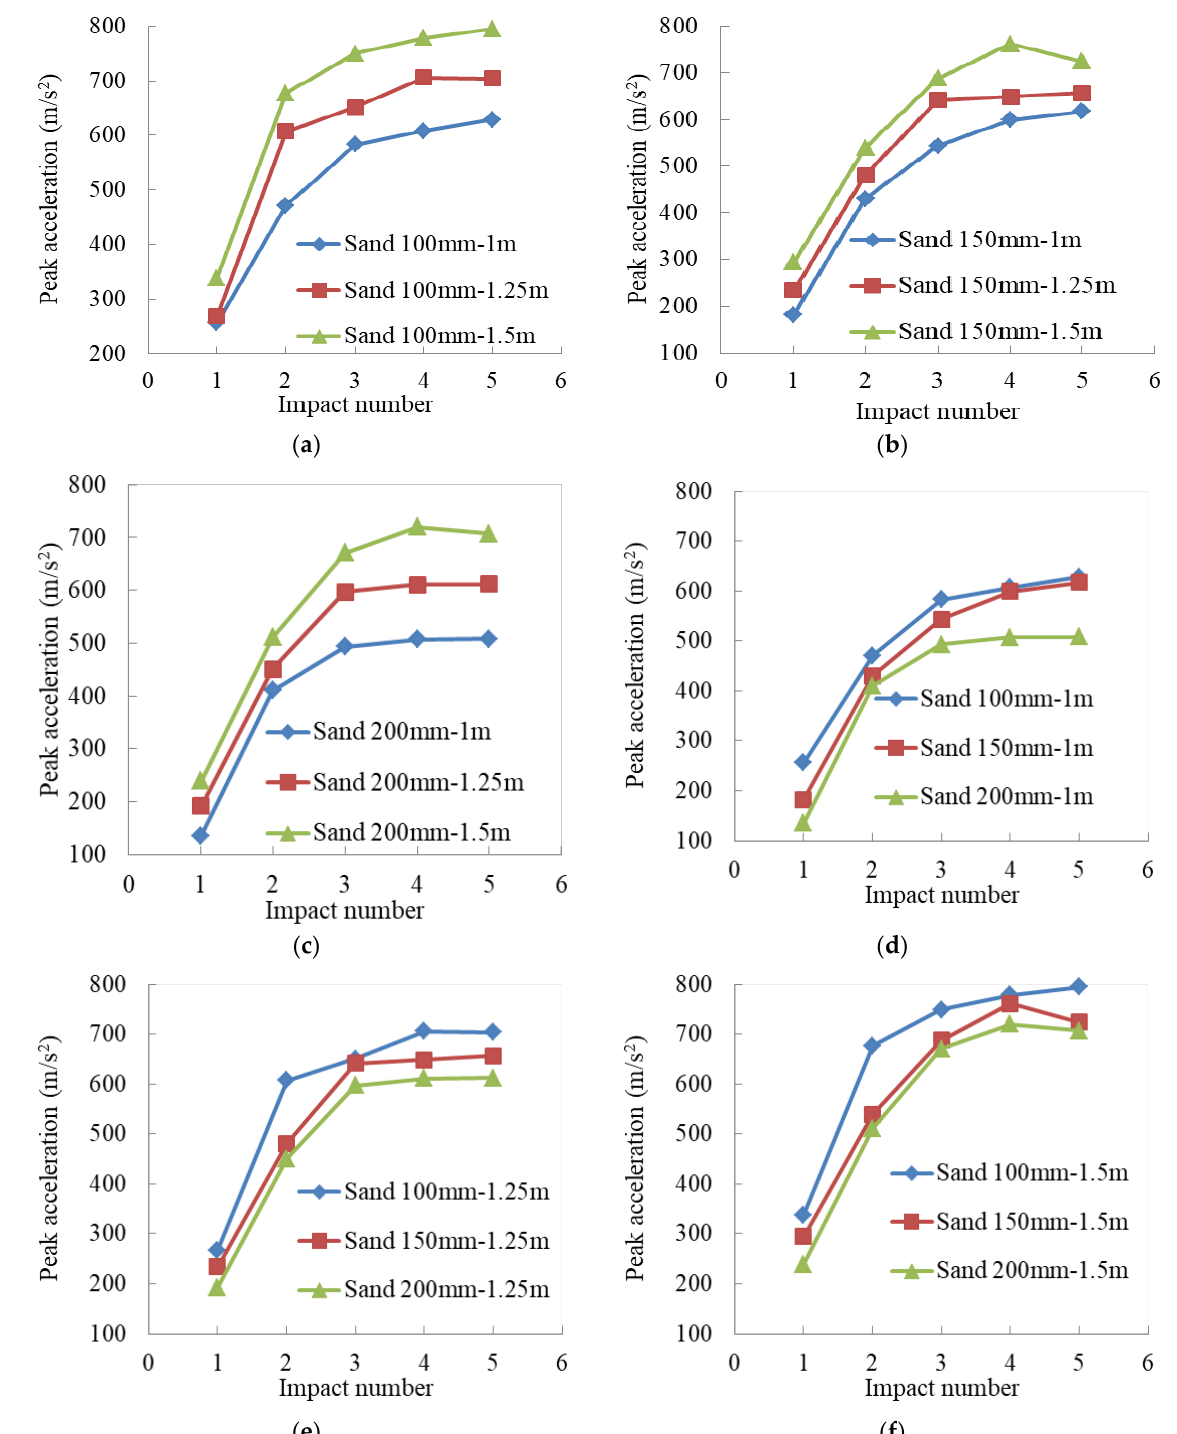
Figure 11. Relation curve between peak acceleration and impact number of different pure sand cushion. ( a ) Sand cushion with 100 mm; ( b ) sand cushion with 150 mm; ( c ) sand cushion with 200 mm; ( d ) impact height with 1 m; ( e ) impact height with 1.25 m; ( f ) impact height with 1.5 m.